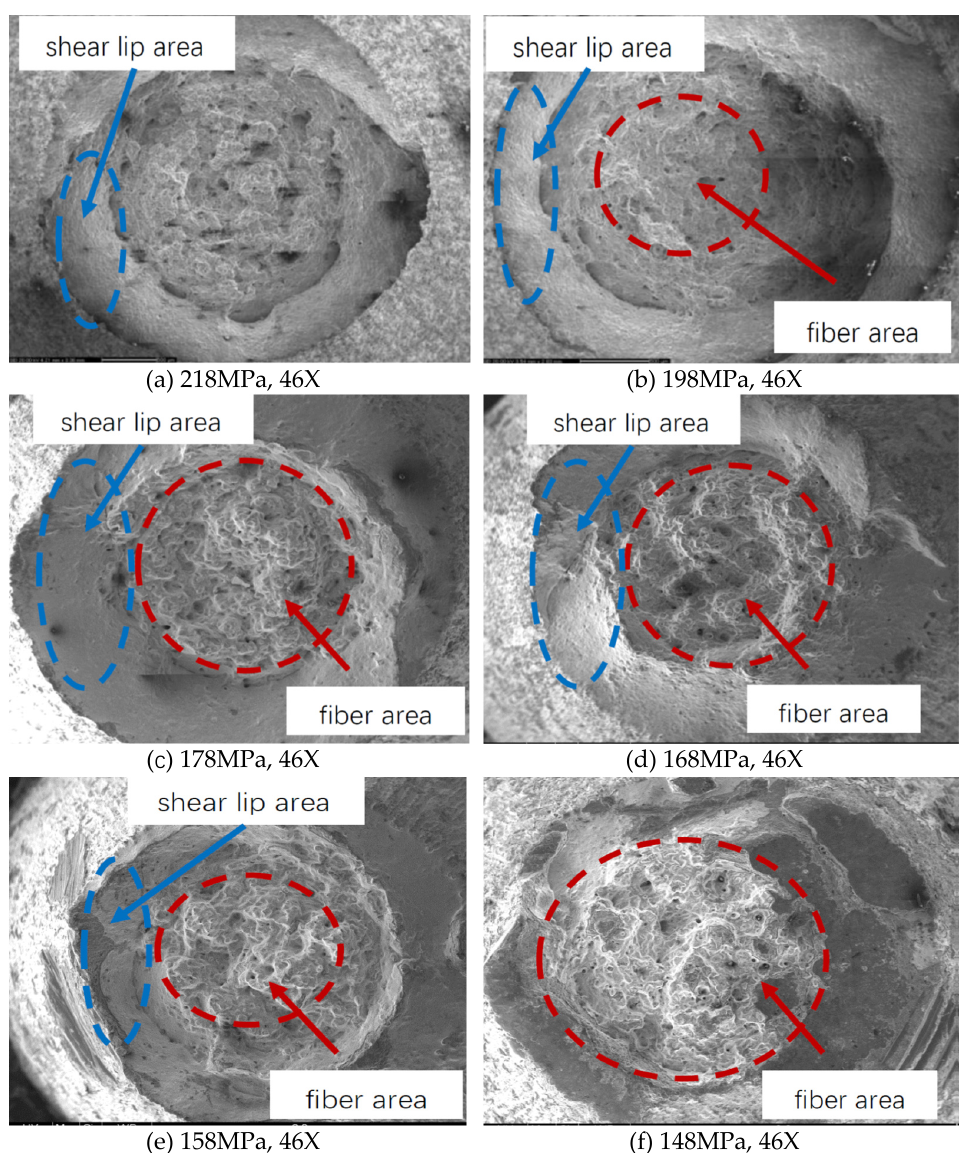
Figure 8. Fracture morphology of the 540 °C creep specimen.